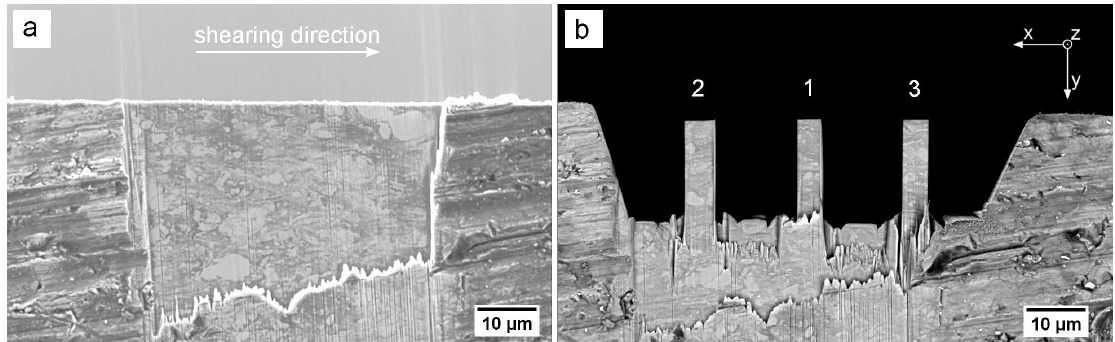
Figure 1. Backscatter electron (BSE) image of a focused ion-beam (FIB) prepared lamella of MgTi depicting ( a ) the microstructure, main shearing direction ( b ) and final micro pillars 1, 2 and 3 before